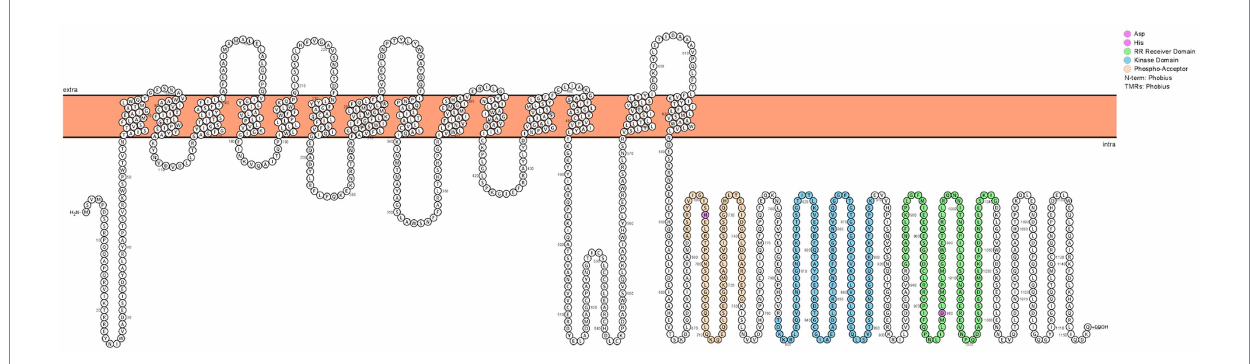
FIGURE 2 AmsS has a Unique Predicted Structure for a Histidine Kinase. Shown is a predicted topology plot for AmsS generated using Protter. The kinase domain is shown in blue, the phospho-acceptor domain in orange, and the response regulator receiver domain in green. Conserved histidine and aspartate residues are shaded in